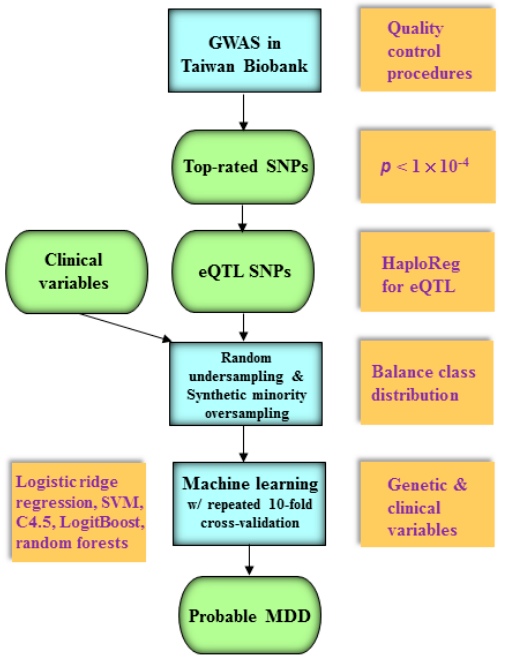
Figure 1. The schematic illustration of an integrated machine learning and genome-wide analysis approach. First, a GWAS is conducted to obtain a set of top-rated SNPs ( p < 1 × 10 − 4 in an odds ratio analysis) in the Taiwan Biobank. Second, HaploReg (compbio.mit.edu/HaploReg, accessed on 11 April 2021) [32] is used to verify if these top-rated SNPs can be considered as eQTLs. Then, random undersampling and synthetic minority oversampling techniques are employed to eliminate instances in the majority class for balancing class distribution. Finally, five machine learning models (logistic ridge regression, SVM, C4.5 decision tree, LogitBoost, and random forests) with the repeated 10-fold cross-validation approach are utilized to predict probable MDD using eQTL SNPs and clinical variables. eQTLs = expression quantitative trait loci; GWAS = genome-wide association study; MDD = major depressive disorder; SNPs = single nucleotide polymorphisms; SVM = support vector machine.